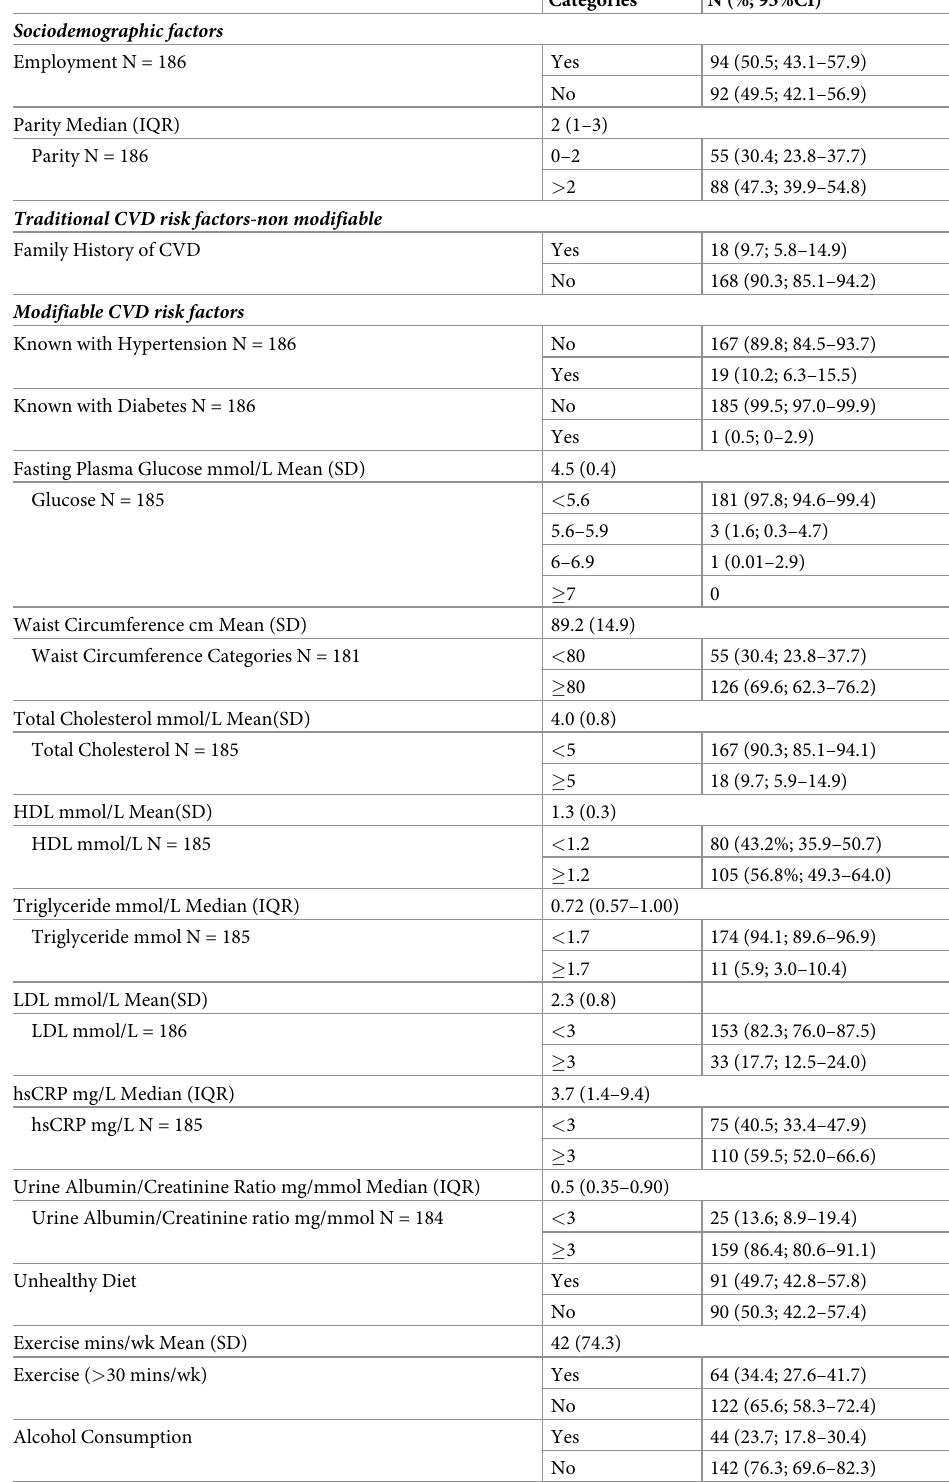
Table 2. Prevalence of additional CVD risk factors investigated in the intervention arm (N =